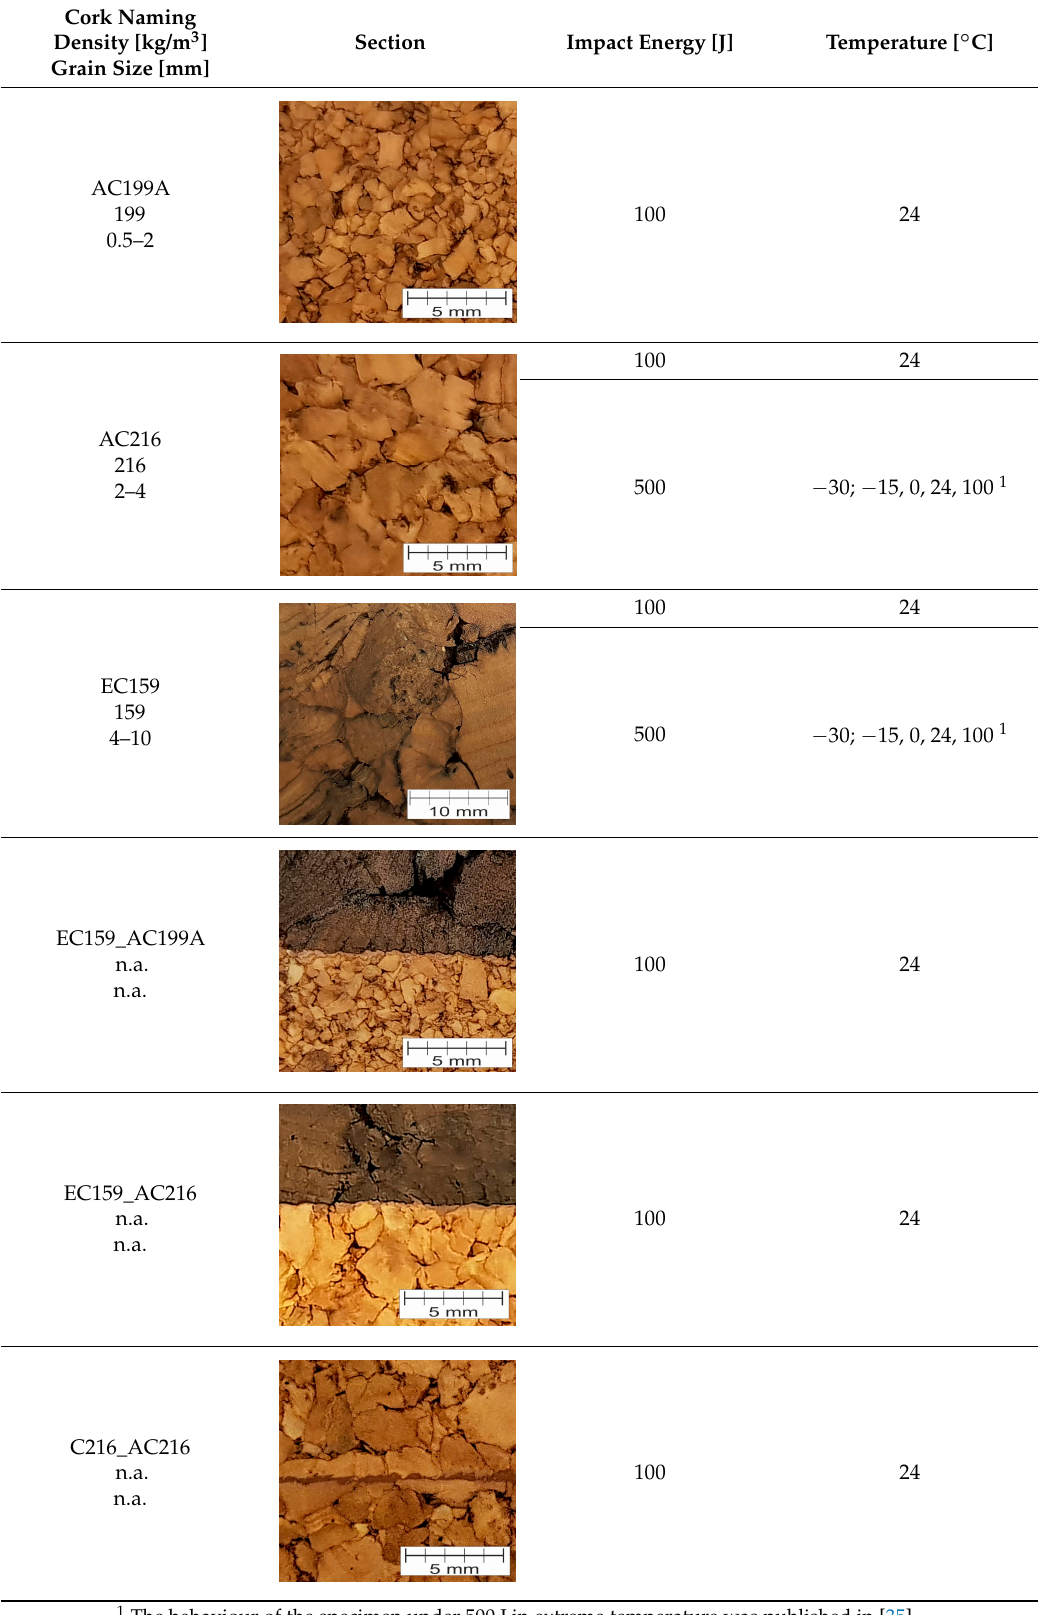
Table 1. Material properties and the tested temperatures.